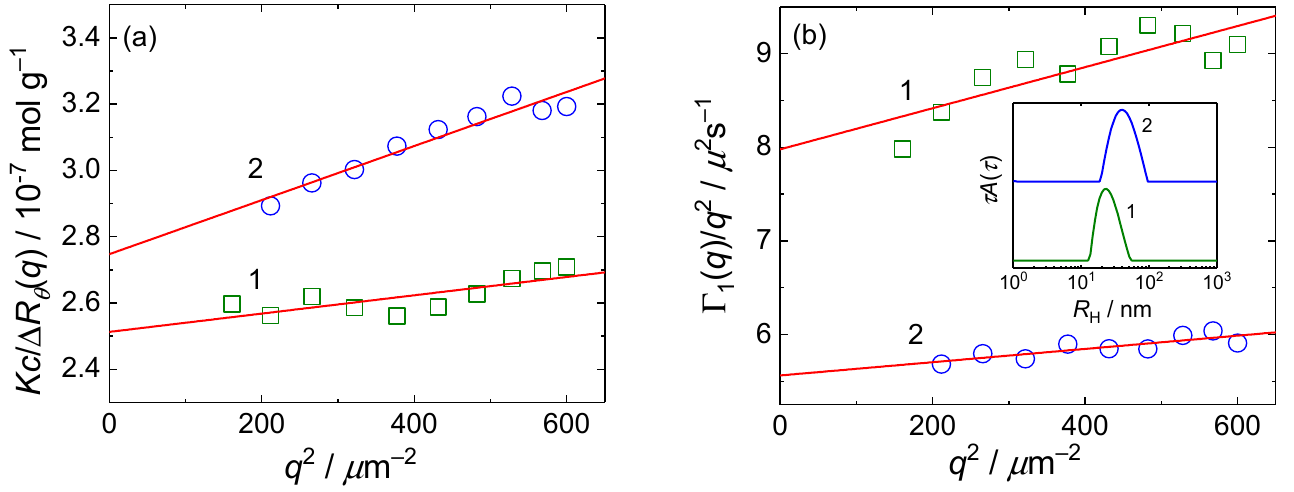
Figure 3. ( a ) Zimm plot and ( b ) dynamic Zimm plot for aqueous solutions of N-SVE-FPBA (curve 1) and A-SVE-FPBA (curve 2) micelles. Insert in ( b ) shows CONTIN distributions of hydrodynamic